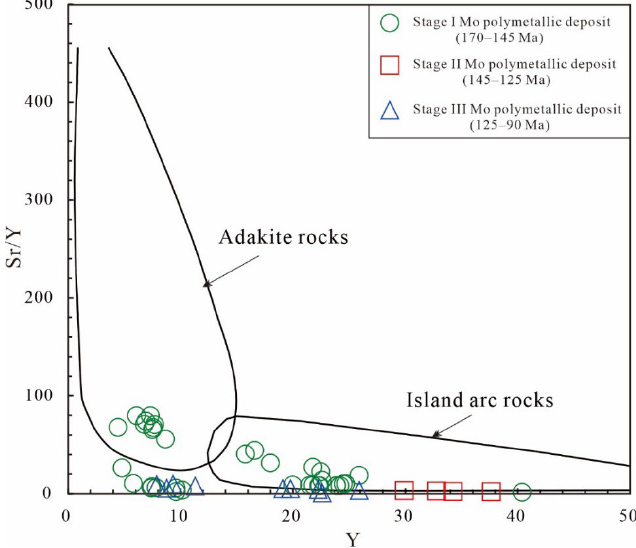
Figure 8. (Sr/Y) vs. Y diagram for the Mo-related Late Mesozoic granites in Zhejiang Province, SE China [45].